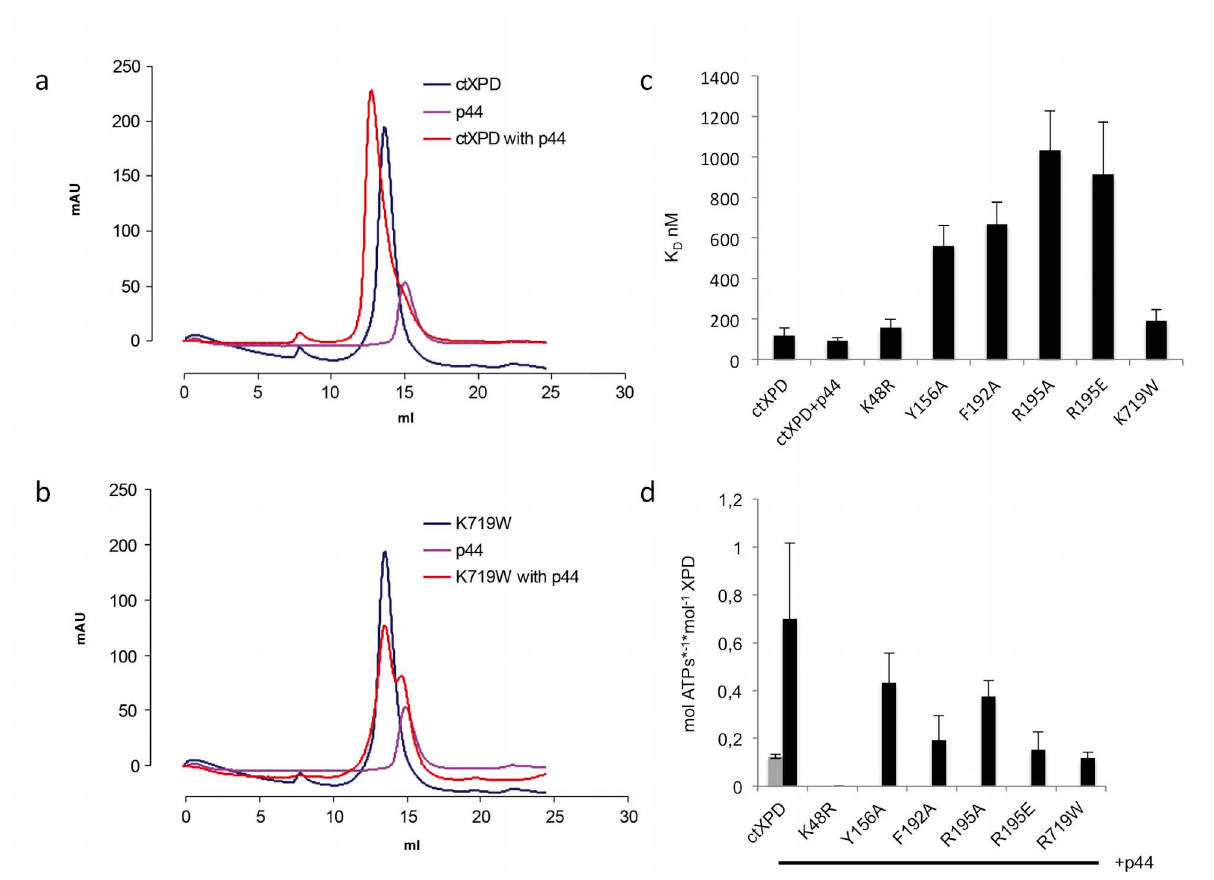
Figure 2. Functional analysis of ctXPD. (a) SEC of ctXPD wild type with ctp44 (1–285). Ctp44 (pink) and ctXPD (blue) were analyzed separately and in a 1:1 stoichiometry (red) mixed prior to SEC. (b) SEC of the ctK719W variant with ctp44 (1–285). The color coding is chosen as in (a). (c) ssDNA binding of ctXPD was analyzed by biolayer interferometry. Measurements were performed in triplicate and with different protein batches. (d) In vitro ATPase assay of ctXPD wild type in the presence (black bars) and absence of ctp44 (1–285) (grey bar). Subsequently all variants were analyzed in the presence of ctp44 (1–285). The data used to generate panels (c) and (d) have been deposited as supplementary information in xls format (Table S1). doi:10.1371/journal.pbio.1001954.g002 Renilla luciferase to normalize transfection efficiencies. A third vector firefly luciferase activity in cell lysates was measured 48 h posttransfec-